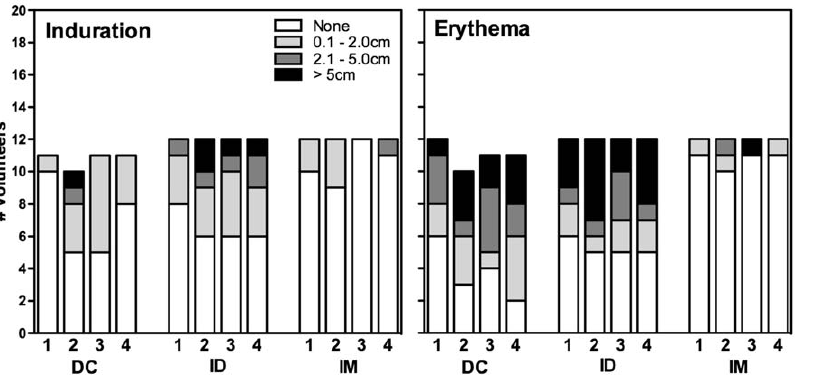
Figure 2. Post-vaccination reactogenicity. Post injection-site reactogenicity symptoms including induration (left panel) and erythema (right panel) after each vaccination for all study groups (autologous DC (DC), intradermal (ID) and intramuscular (IM) routes).